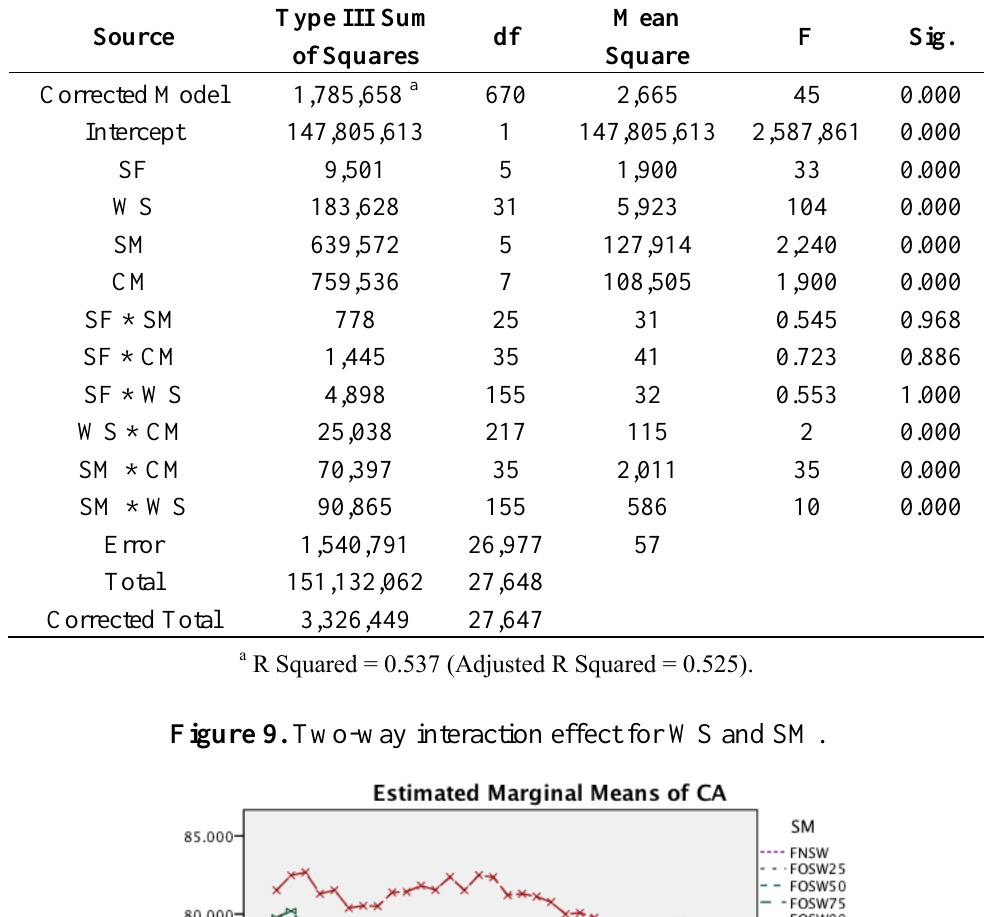
Table 3. ANOVA output for the CA as the dependent variable ( Tests of Between-Subjects Effects. Dependent Variable: CA ).